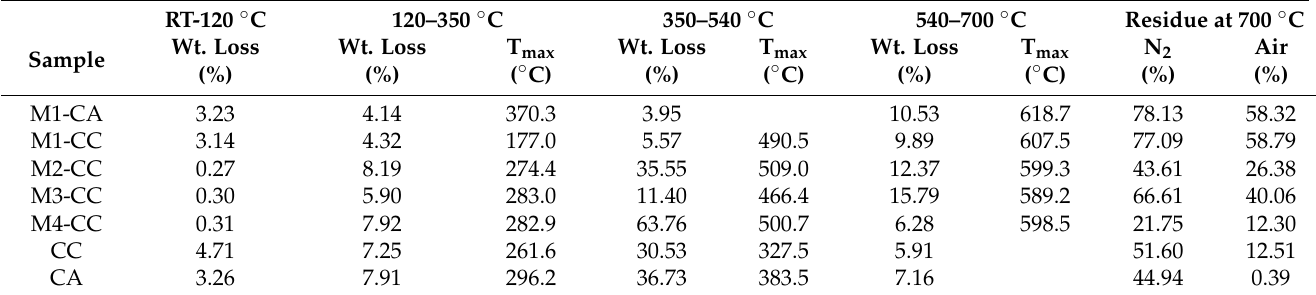
Table 2. Characteristic decomposition temperatures and mass